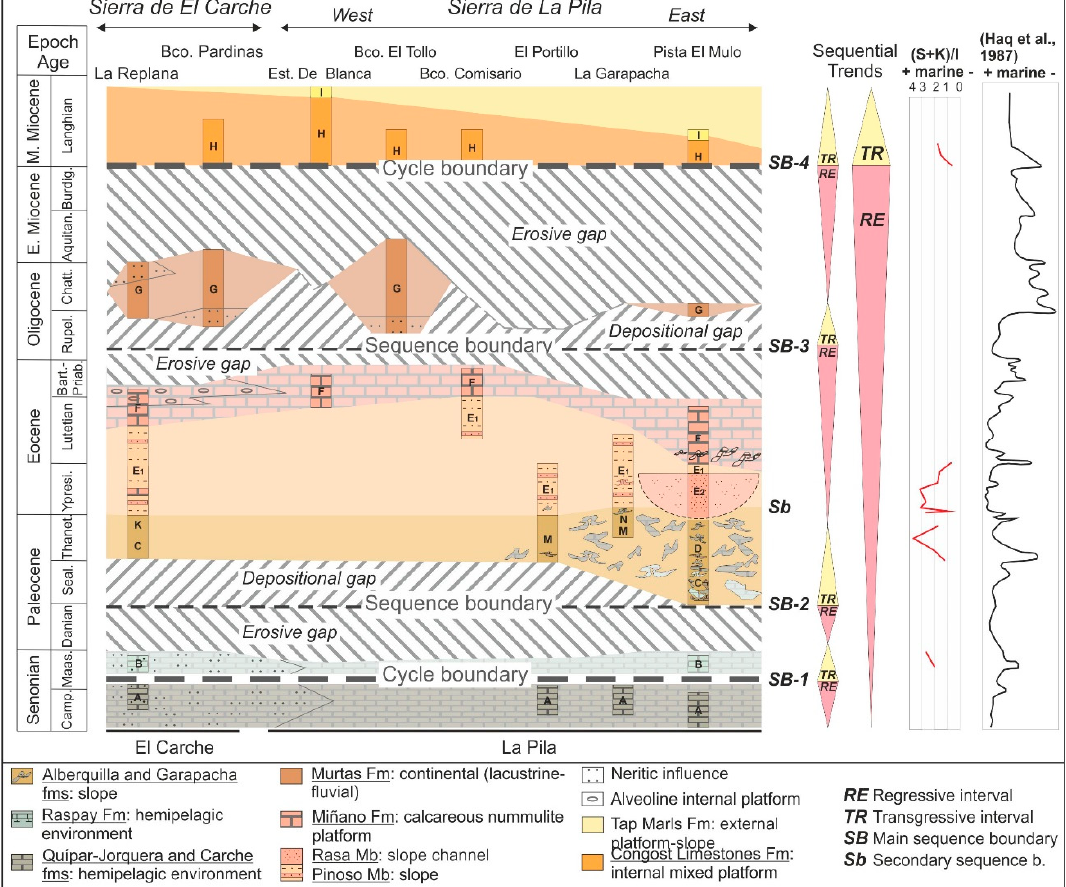
Figure 4. Stratigraphic framework and regional correlation of the Paleogene-Aquitanian sedimentary suite in the Pila-Carche Basin (Murcia sector) of the eastern EBZ (after Reference [19]; modified). Two sections are presented in the Sierra de El Carche (La Replana and Barranco Pardinas) and six sections in the Sierra de la Pila (Estación de Blanca, Barranco de El Tollo, El Portillo, La Garrapacha and Pista del Mulo). In the correlation, the main and secondary sequence boundaries (SB, Sb, respectively) are shown. Also, the erosive and depositional gaps are mentioned. In the right part of the figure, the transgressive (TR) or regressive (RE) trending are marked, and also, the correlation with the standard eustatic curve.